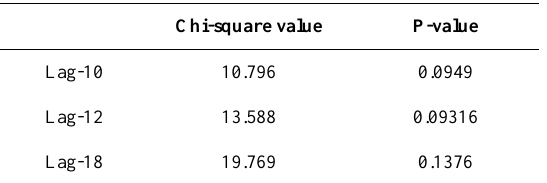
Table 4. The Chi-square values and P-values of Lijung-Box